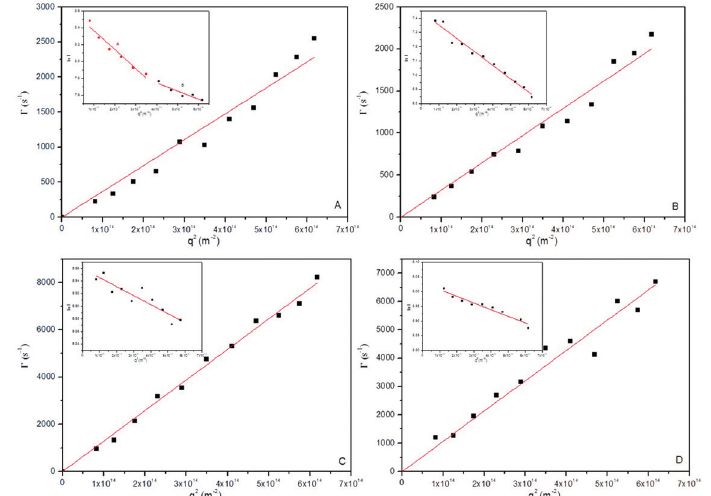
Figure 5: Dependence of the relaxation frequency (1/τ) on the squared wave vector modulus (q 2 ) of the aqueous suspensions of (A) PEO - b -PLA filtered through a 0.45 μm membrane; (B) PEO - b -PLA containing 10% lavender essential oil filtered through 5KDa 4.5KDa 5KDa 4.5KDa a 0.45 μm membrane; (C) PEO - b -PLA filtered through a 0.45 μm membrane; and (D) PEO - b -PLA containing 10% lavender 5KDa 10KDa 5KDa 10KDa essential oil filtered through a 0.45 μm membrane. Table 2: Hydrodynamic radius determined by DLS and zeta potential experiments, hydration radius (SLS), polydispersity and anisotropic degree.